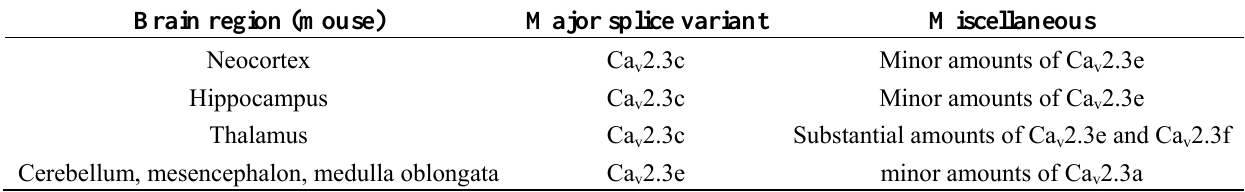
Table 2. Transcripts of major splice variants of voltage-gated Ca expressed in different brain regions